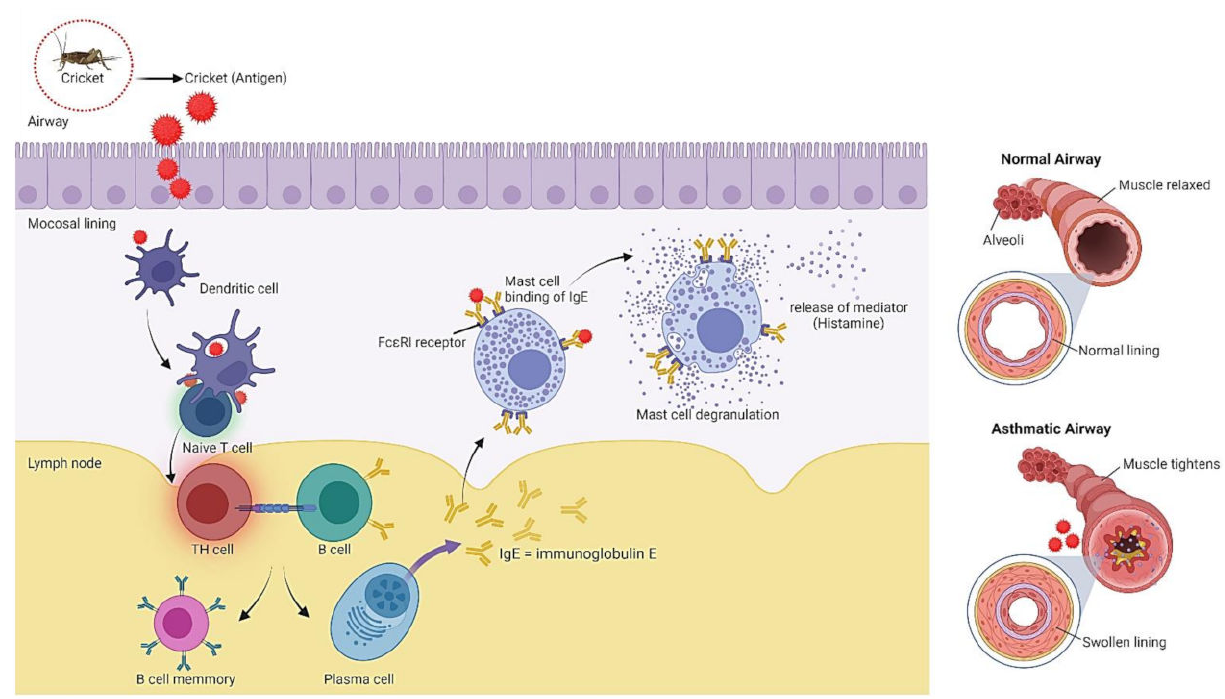
Figure 7. IgE-mediated hypersensitivity by crickets. Dendritic cells recognize cricket antigens, which subsequently lead to the activation of adaptive immune system. Repeated exposure to cricket antigens activates mast cells, resulting in the production of histamine and tightened smooth